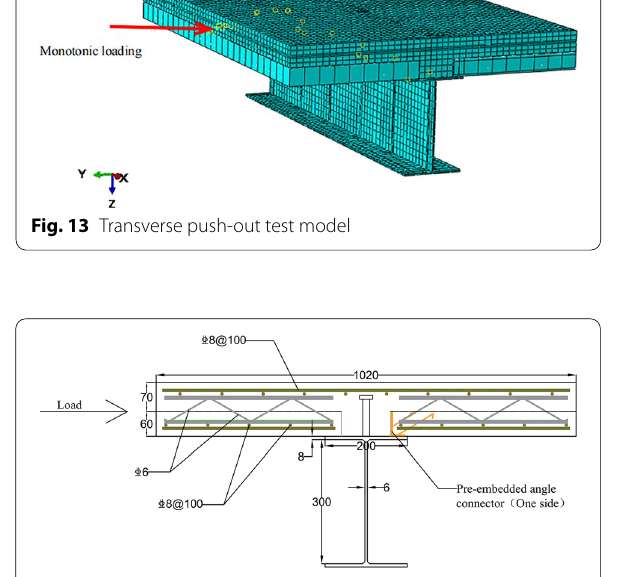
Fig. 14 Position of the angle connector in the